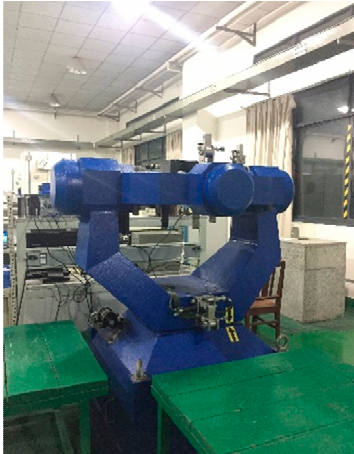
Figure 10. The single-axis RINS installed on the three-axis turntable. Table 9. The quasi-static and swing condition of the turntable.